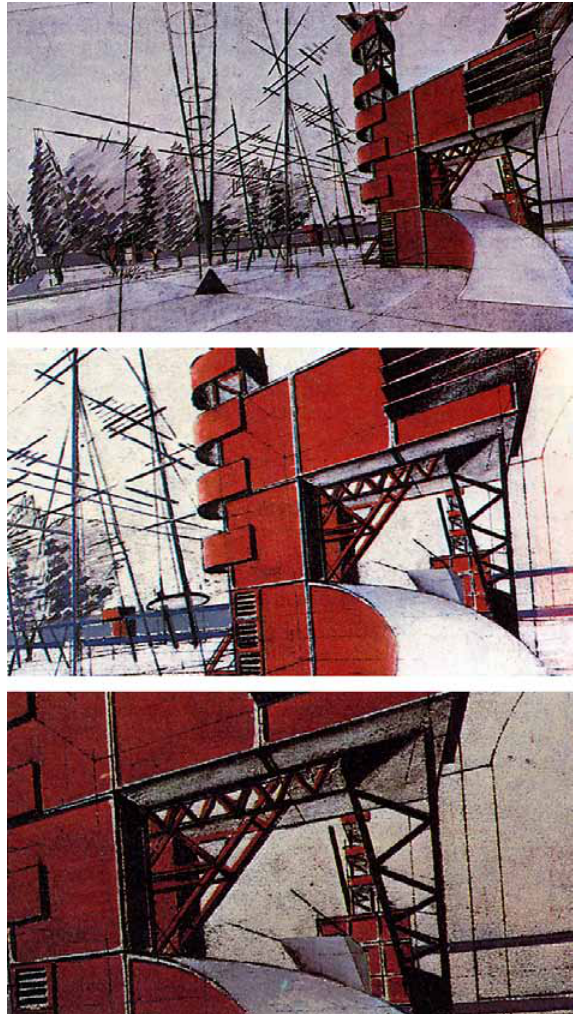
fig. 7. Drawings for the Parc de la Villette , Bernard Tschumi, 1984. © Bernard Tschumi architects. Note: The stationary quality of a two-dimensional representation is compensated for through a series of oblique frames that emphasize the movement of the viewer’s visual field.